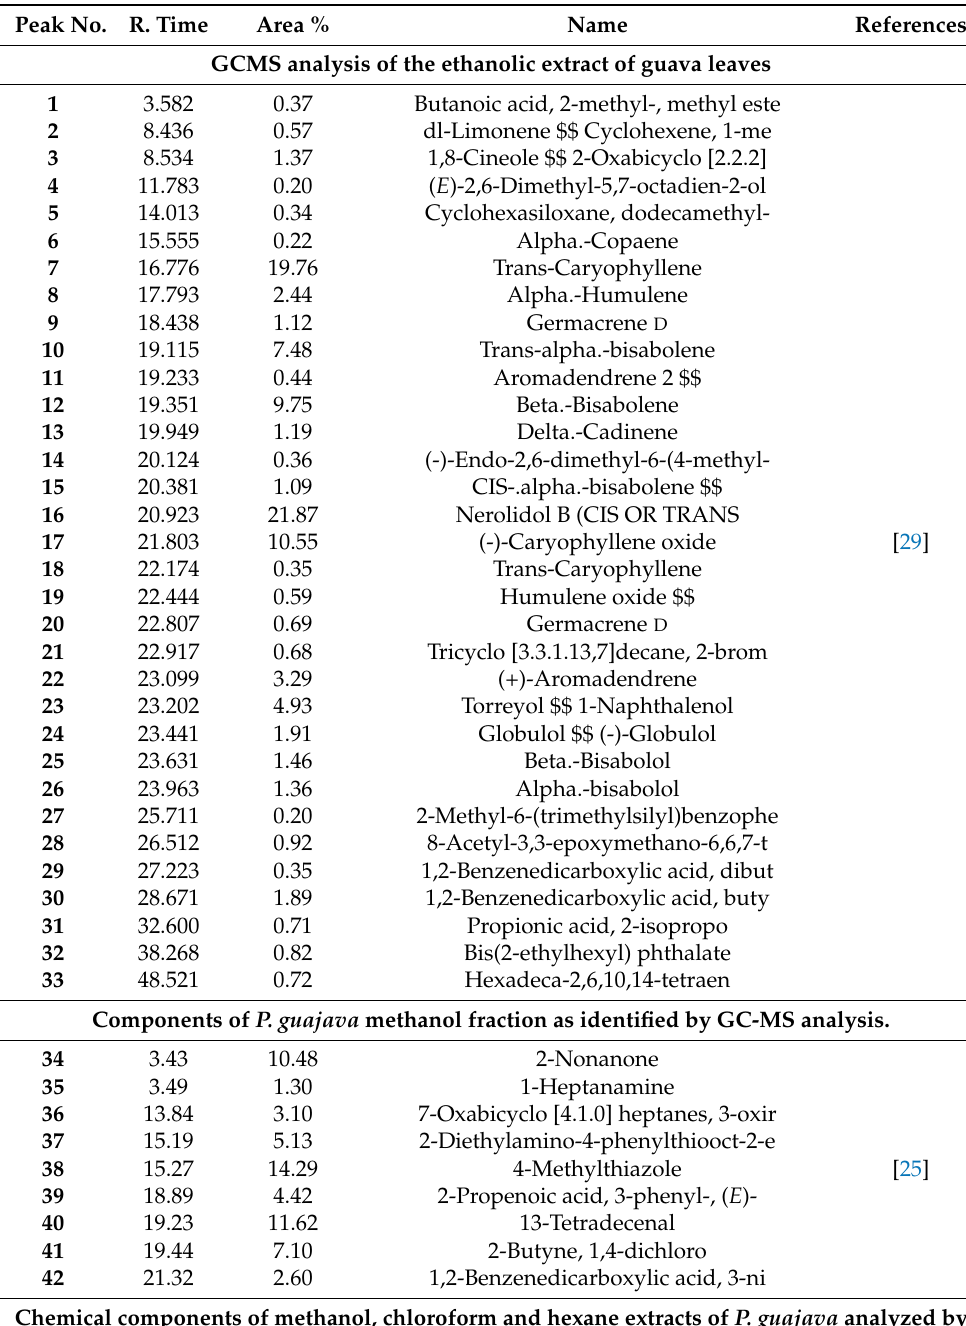
Table 3. GCMS analysis of the leaves extracts of Psidium guajava . Peak No. R.